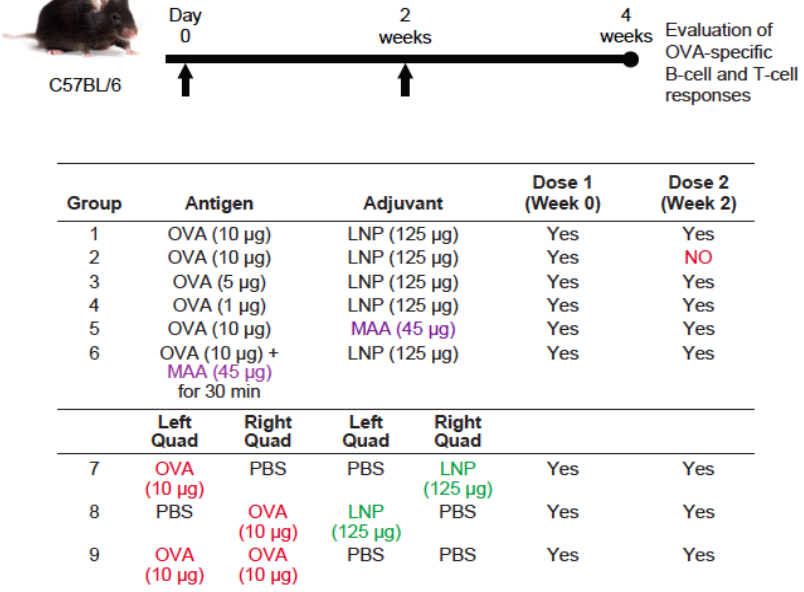
Figure 4. Immunization groups and vaccination regimes evaluated in C57BL/6 mice. OVA: